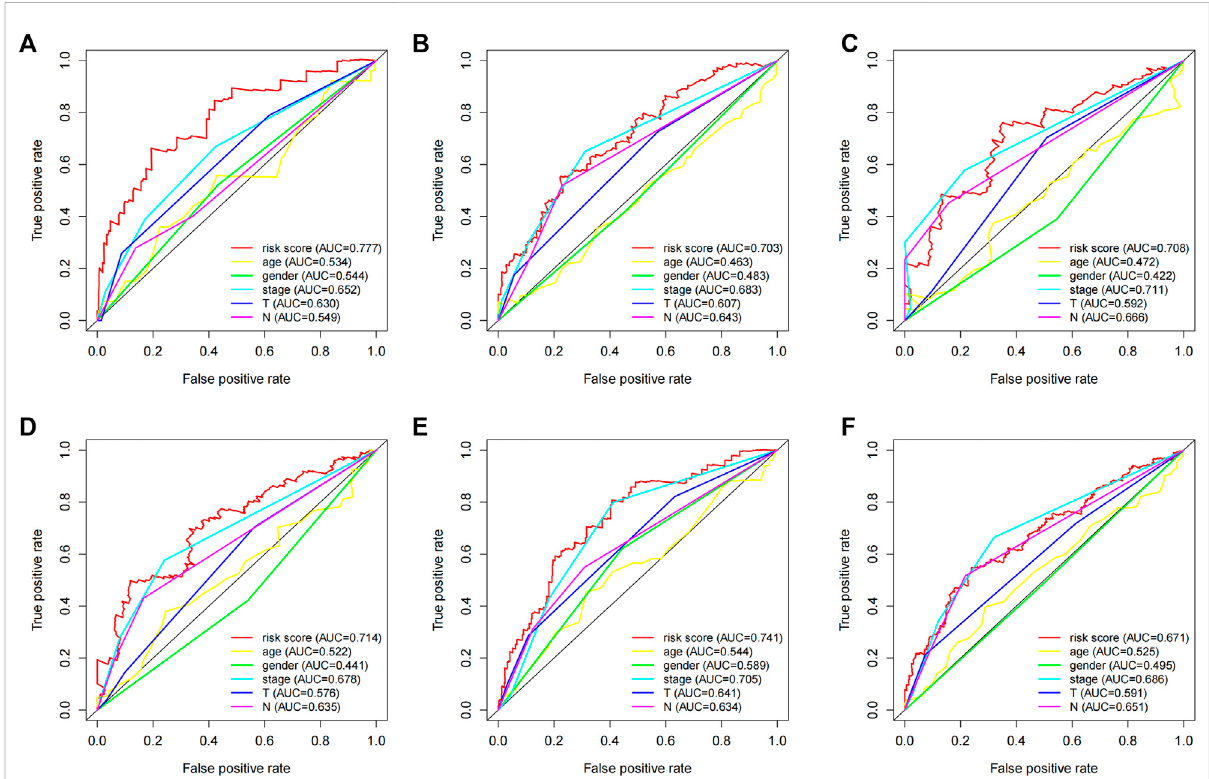
FIGURE 6 Theprognosticvalueofthe5-lncRNAsignatureincomparisonwithotherclinicalfactors.Time-dependentROCcurveanalysisofthe5-lncRNA signature for predicting (A) 1 year-OS, (B) 3 years-OS, and (C) 5 years-OS in the “ primary dataset ” . Time-dependent ROC curve analysis of the 5- lncRNA signature for predicting (D) 1 year-OS, (E) 3 years-OS, and (F) 5 years-OS in the “ entire dataset ”